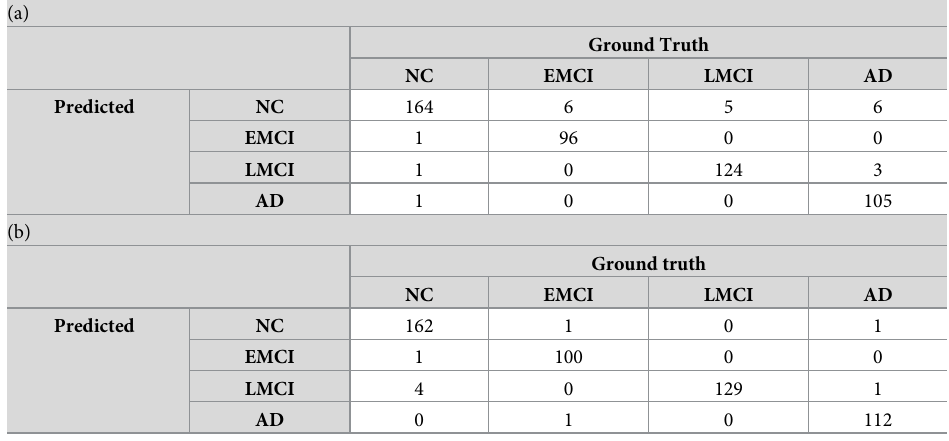
similar studies employing the same dataset is found in Table 6.